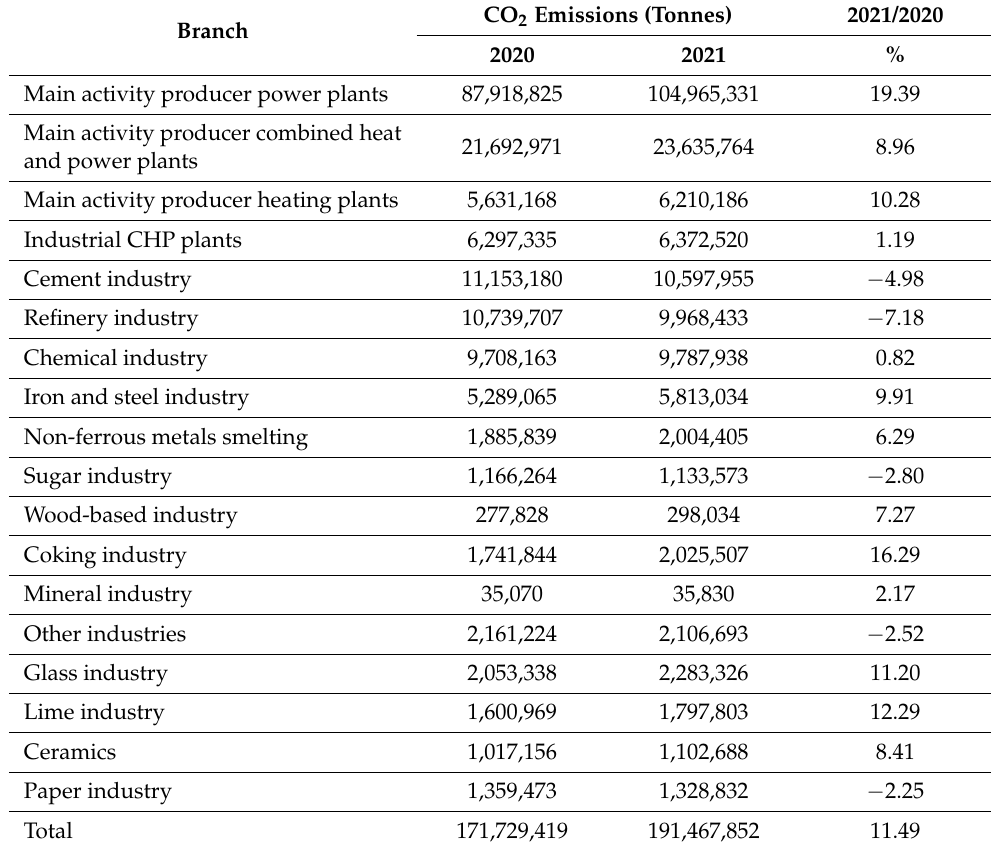
Table 1. CO 2 emissions in Polish industry by